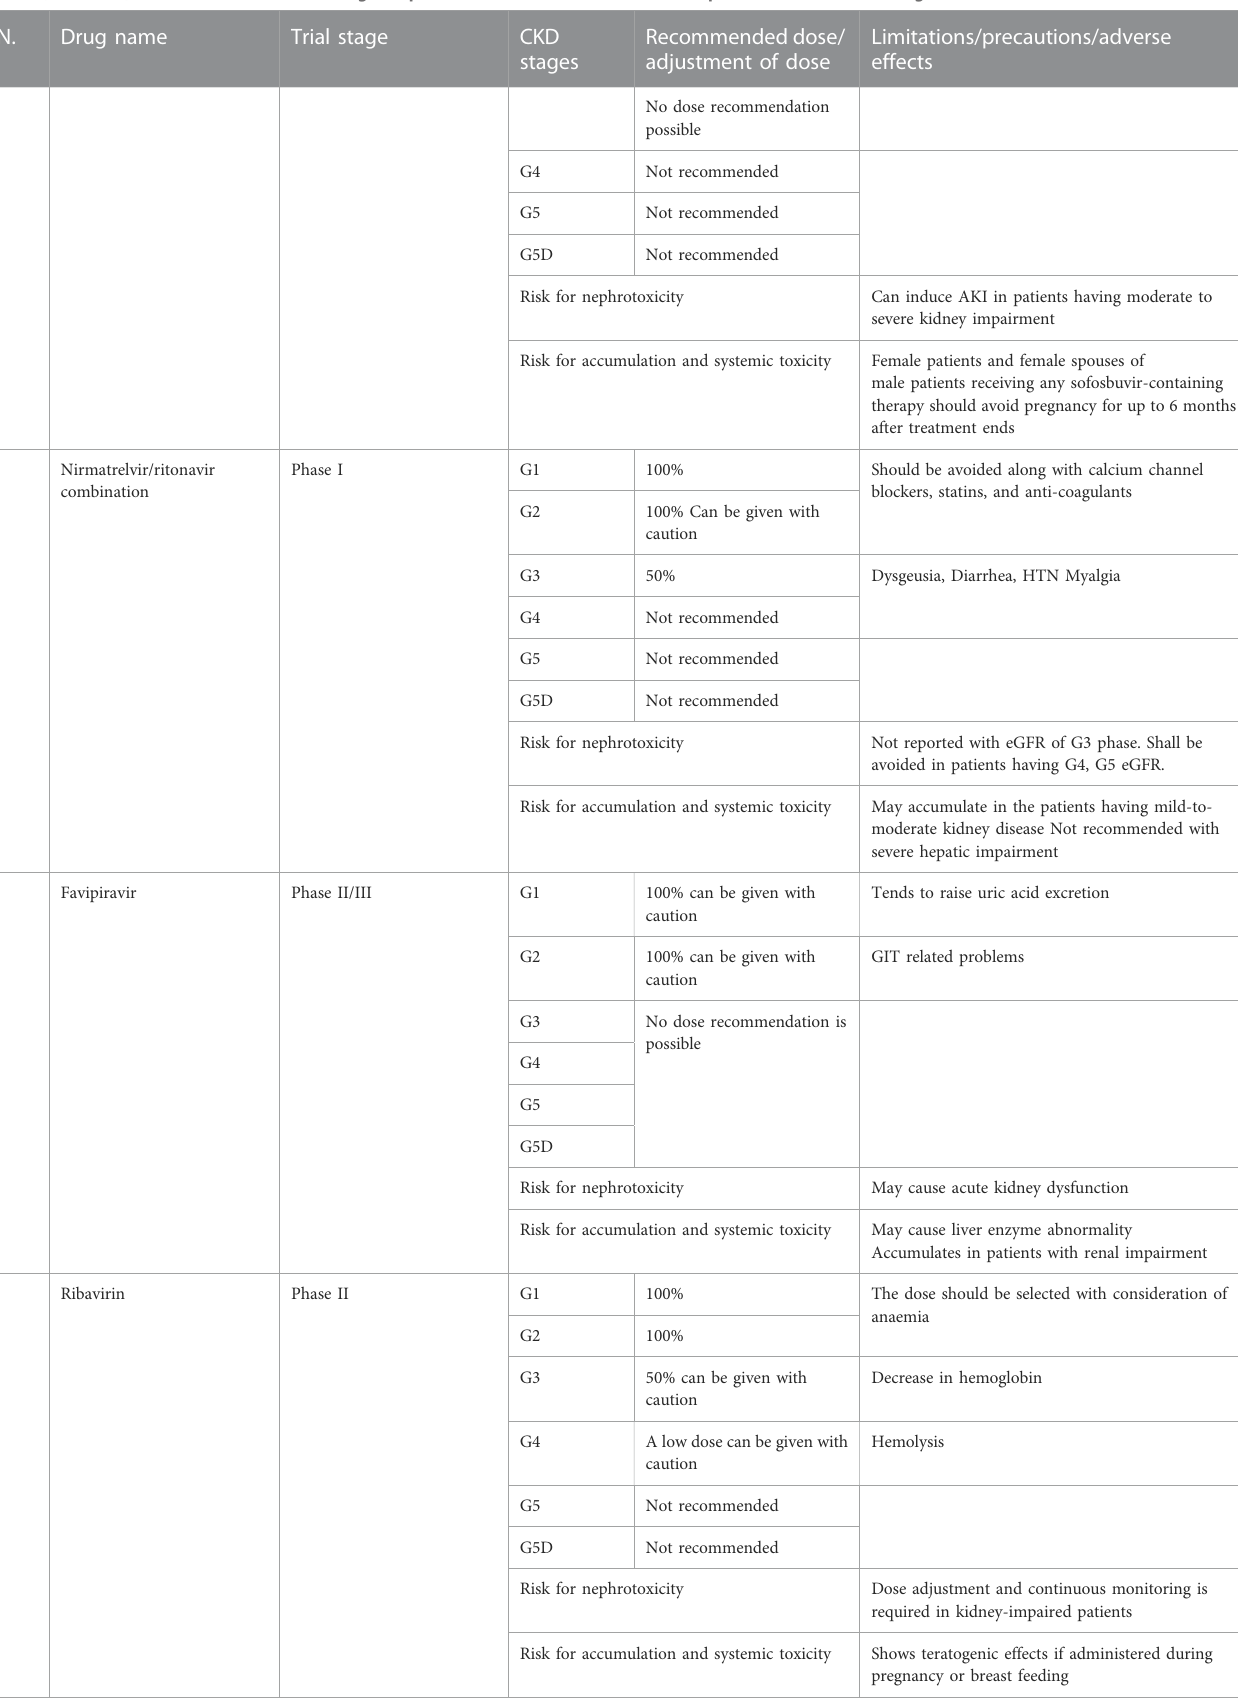
TABLE 1 ( Continued ) Recommendations for dosing and precautions of antivirals in COVID-19 patients with different stages of CKD.